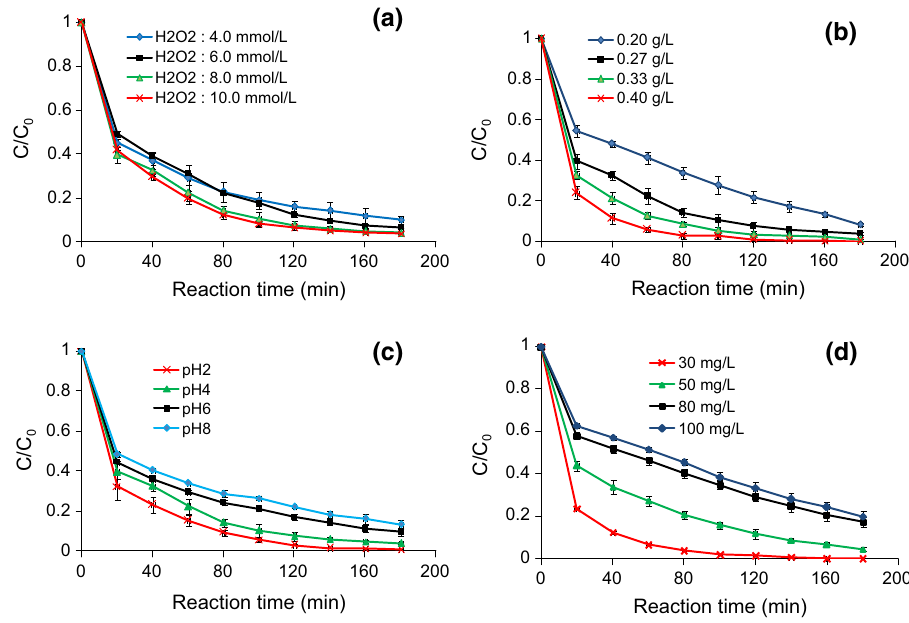
Fig. 8 Effect various param- eters on the removal kinetics of Rhodamine B catalyzed by AC@Fe/3: a H 2 O 2 concentra- tion at pH = 4.2 and 28 °C, C 0 = 50 mg/L, 0.27 g/L of catalyst, b effect of the catalyst dose at pH = 4.2 and 28 °C, C 0 = 50 mg/L, 8 mmol/L of H 2 O 2 , c effect of pH at 28 °C, C 0 = 50 mg/L, 0.27 g/L of catalyst, 8 mmol/L of H 2 O 2 , d effect of the Rhodamine B initial concentration at pH = 4.2 and 28 °C, 0.27 g/L of catalyst, 8 mmol/L of H 2 O